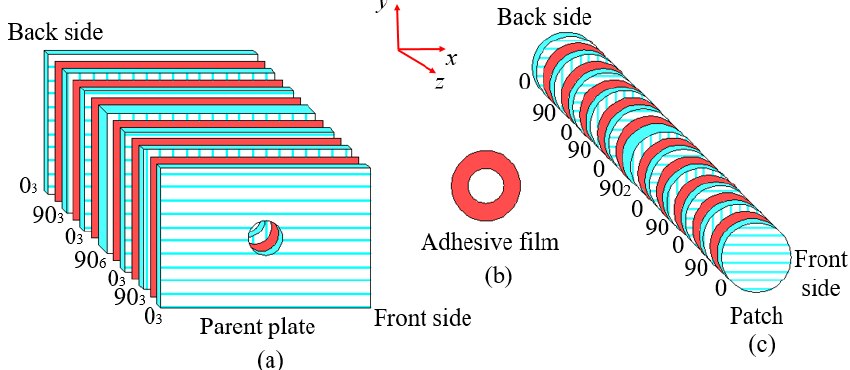
Figure 6. Composite layers and interface layers of ( a ) the parent plate, ( b ) patch and ( c ) adhesive